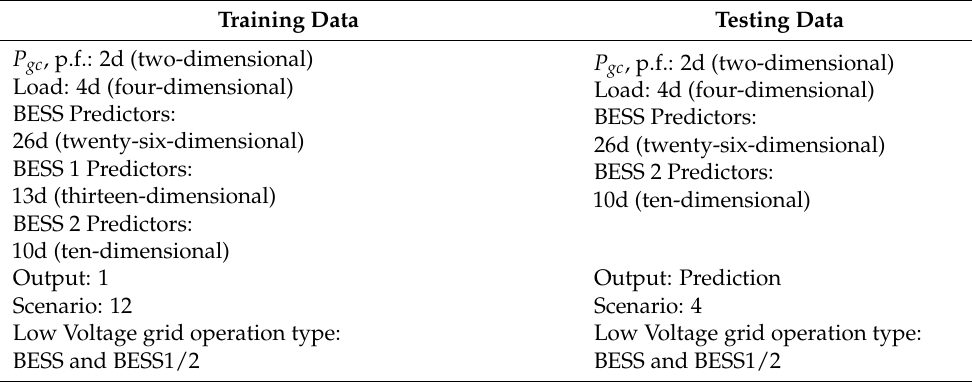
Table 2. Characteristics of the training and test